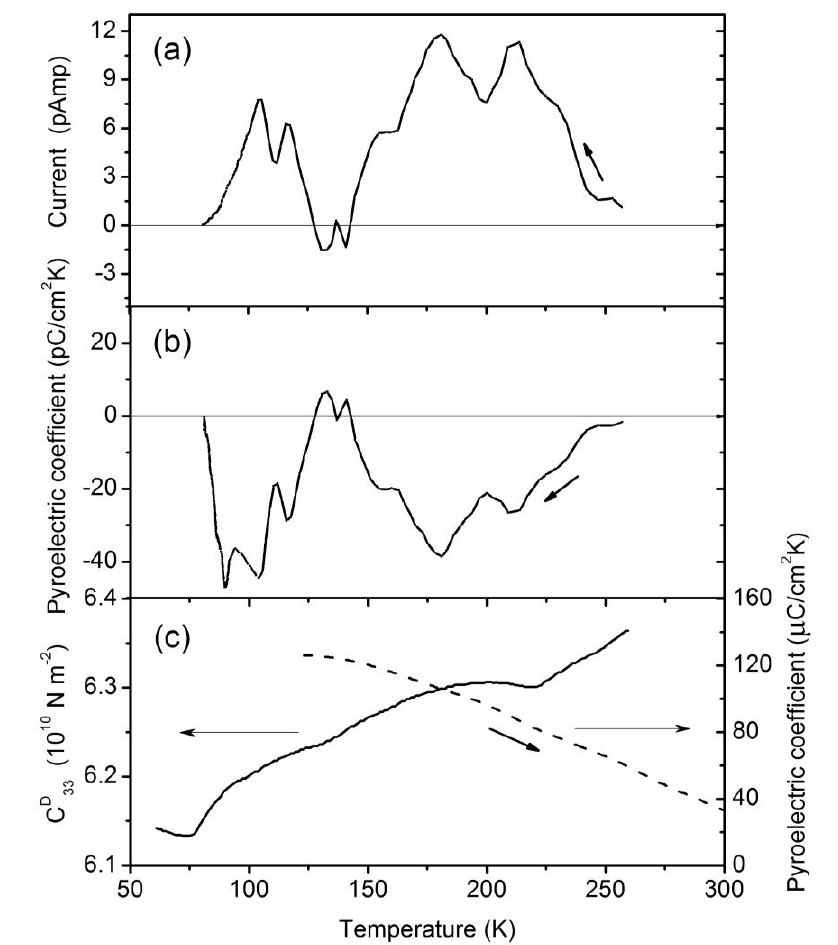
B O single crystal in 2 4 7 B O single crystal along the C 33D for the Li 2 4 7 